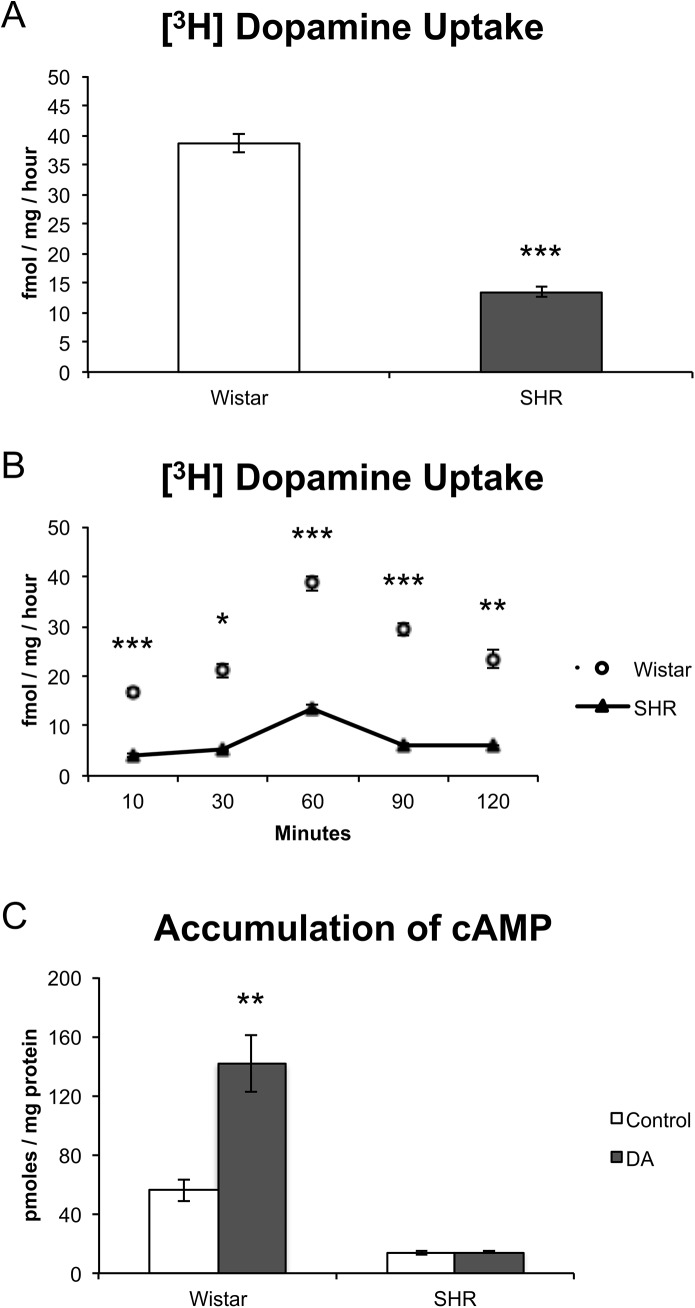
Characterization of [3H]-Dopamine uptake and cAMP accumulation in naïve Wistar and SHR rats.(A) [3H]-Dopamine uptake after 60 min in the PFC (n = 6–8). (B) Time curve of [3H]-Dopamine uptake (n = 3–6). (C) cAMP levels in PFC slices in basal conditions and after exogenous dopamine stimulation (200 μM) (n = 4–8). Results are expressed as means ± S.E.M. A and B: * = p < 0.05; ** = p < 0.01; *** = p < 0.001, SHR vs. Wistar. C: ** = p < 0.01, Control vs. DA.